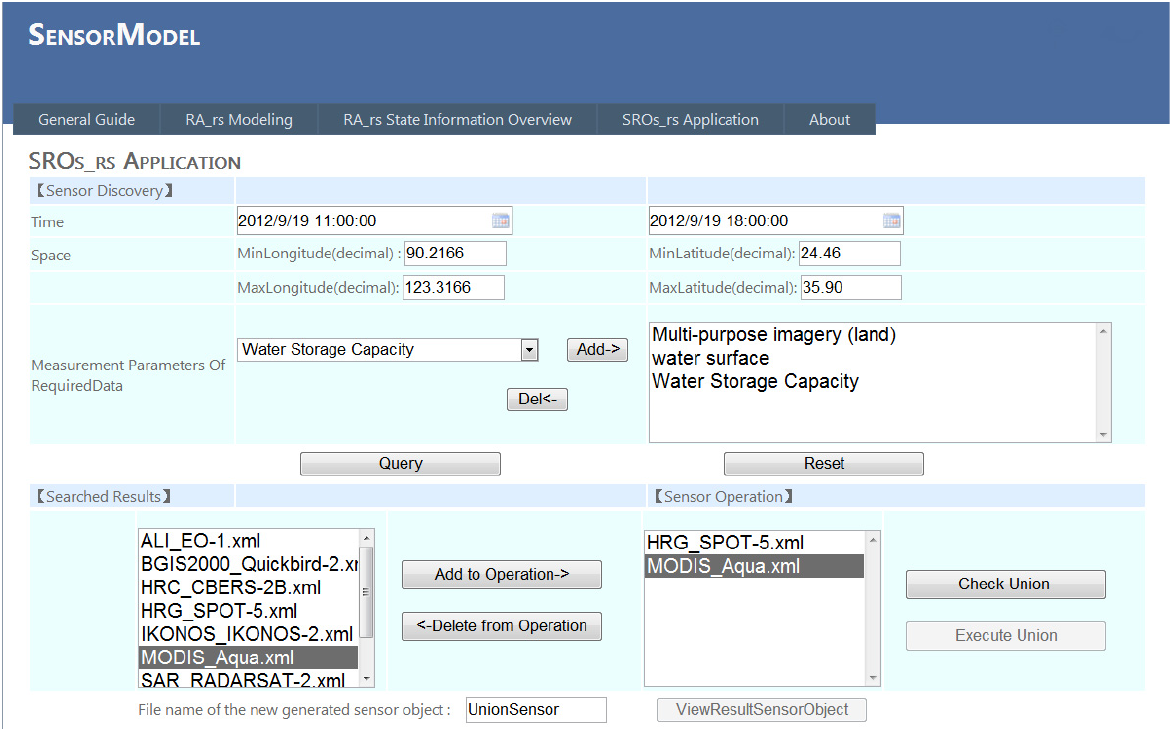
Figure 6. Sensor application based on the proposed